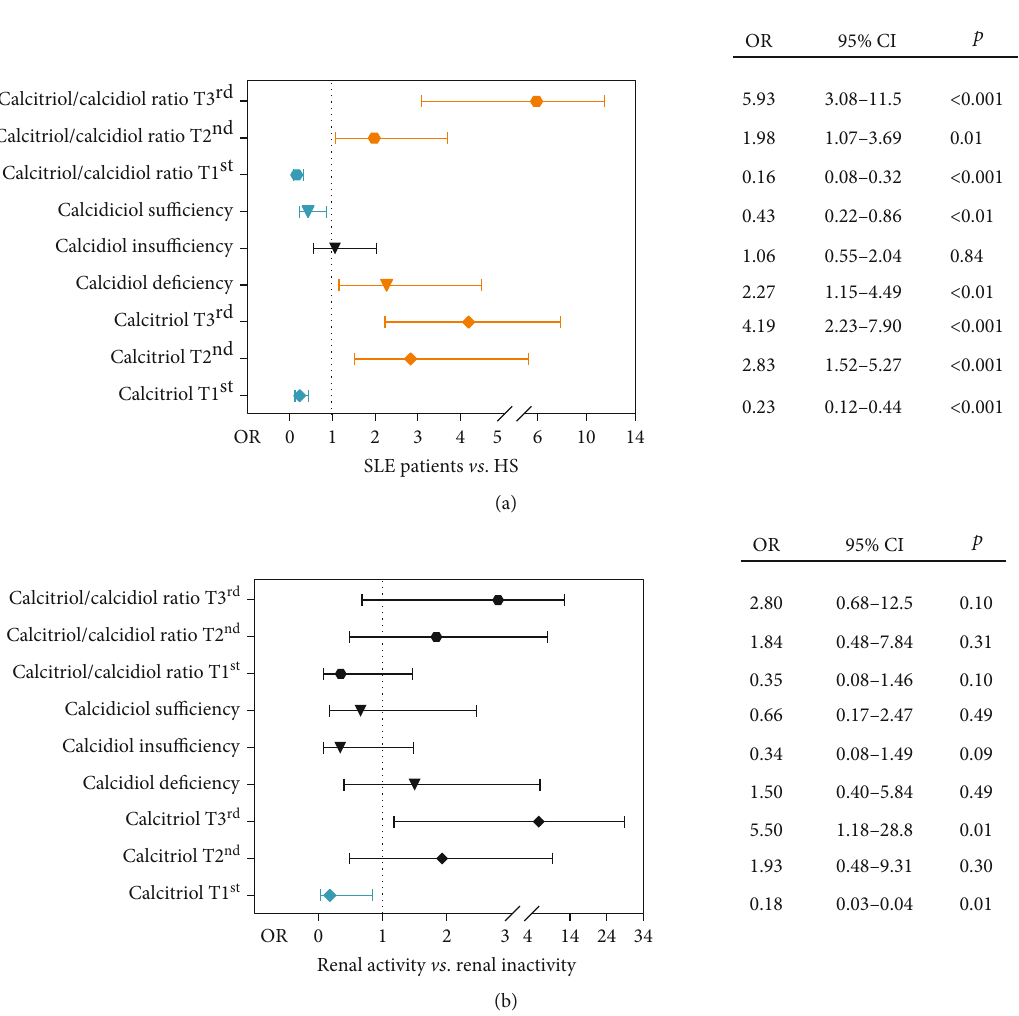
= 0 : 04 , p = 0 : 01 and β coefficient = 1 : 76 , R 2 = 0 : 09 , p < 0 : 01 ,